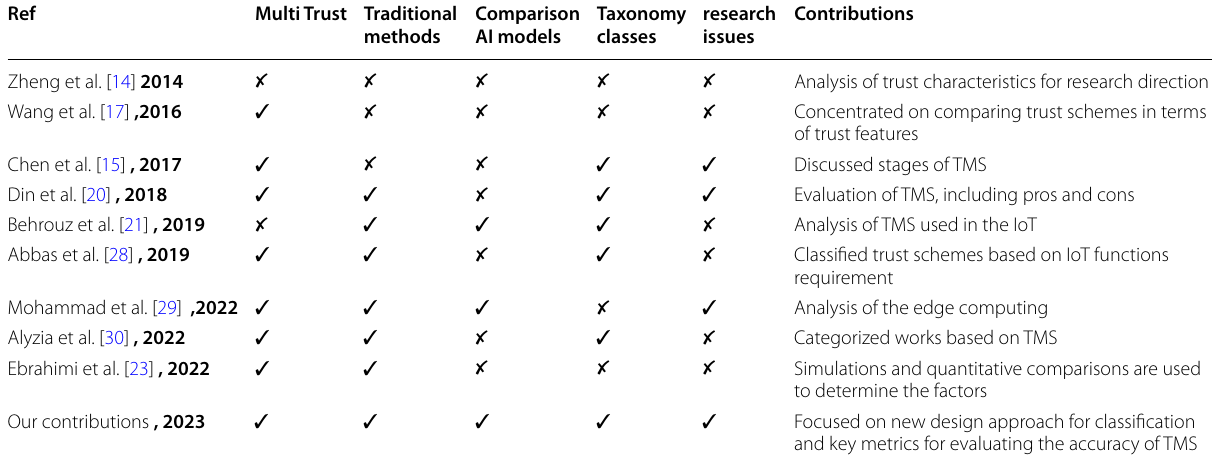
Table 1 Summary of related TMS surveys Ref Multi Trust Traditional